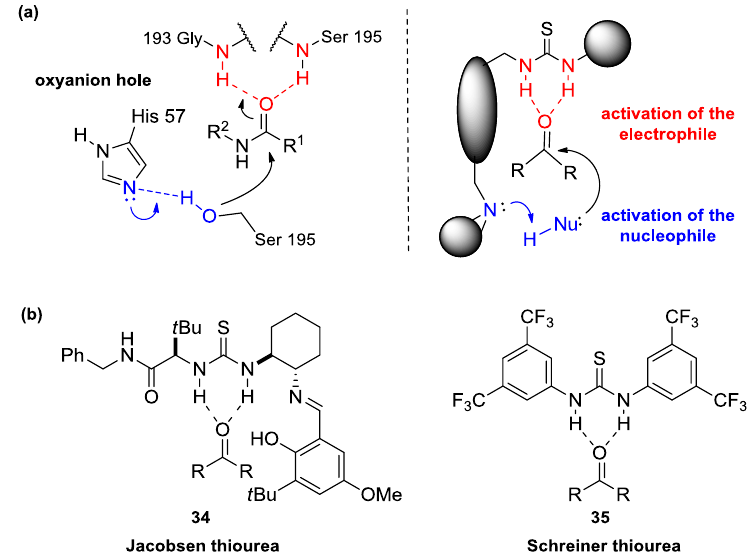
Figure 11. (a) The so-called ‘ oxyanion hole ’ in serine protease activating a carbonyl; (b) hydrogen bonding organocatalysts activating a carbonyl.